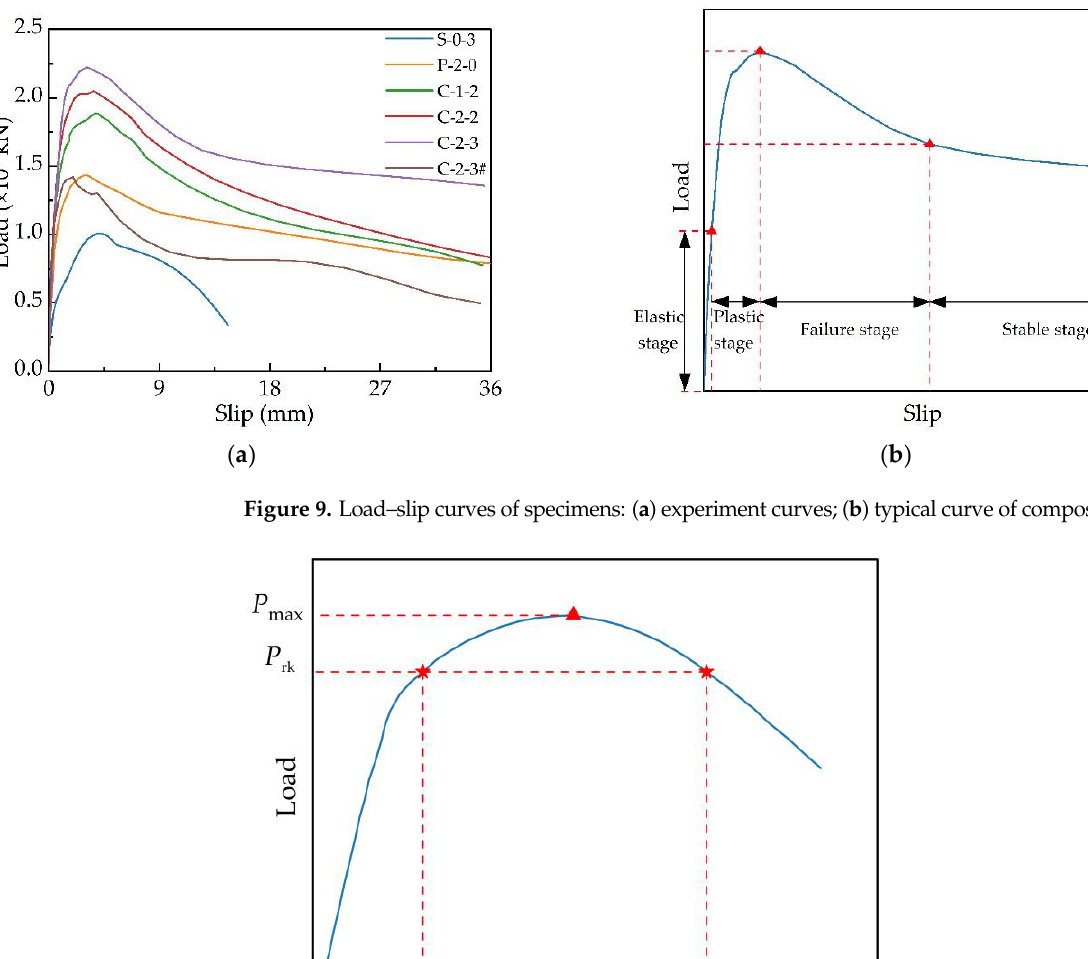
Figure 9. Load – slip curves of specimens: ( a ) experiment curves; ( b ) typical curve of composite con- nectors.